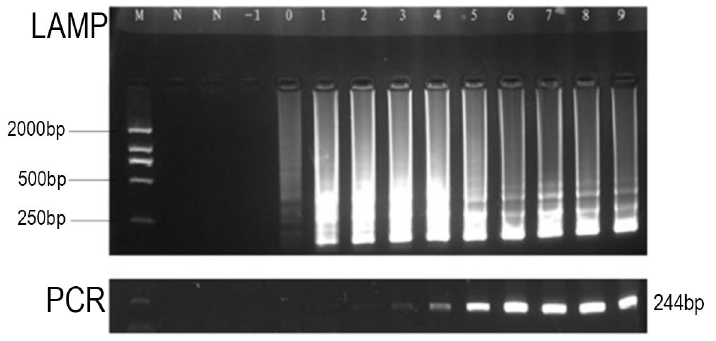
Figure 2. Comparison of the detection limit of LAMP and general PCR. Lane M, DL 2000 bp ladder marker; lanes 10 9 , 10 8 , 10 7 , 10 6 , 10 5 , 10 4 , 10 3 , 10 2 , 10 1 , 10 0 and 10 2 1 indicate the number of gene copies/ m l; lane N, negative